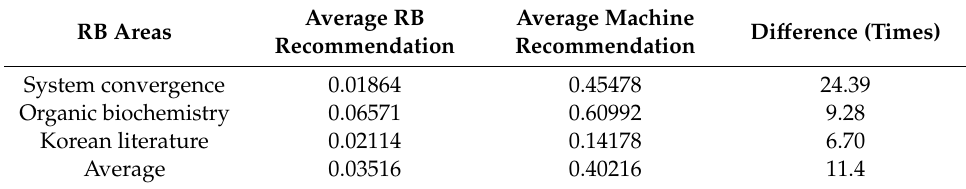
Table 1. The results of the recommendation from the Review Board (RB) and developed